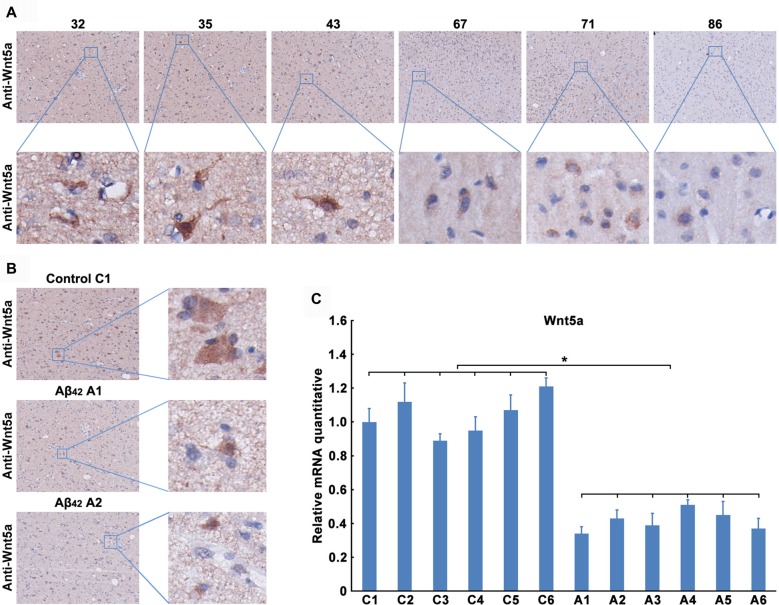
Aβ42 inhibited the expression of Wnt5a in vivo. (A) Wnt5a immunoreactivity was primarily detected in the adjacent normal brain tissues of malignant glioma from 32, 35, 43, 67, 71 and 86 years old patients (magnification of upper panel: ×40; magnification of lower panel: ×400). (B,C) A solution of Aβ42 (3 nmol/10 μl) or Aβ42 (3 nmol/10 μl) combined with recombinant Wnt5a protein (6 nmol/10 μl) was injected into the lateral ventricles of mice. Seven days after treatment, Wnt5a immunoreactivity was primarily detected in mouse brain tissues (B, control C1: control group mouse 1; Aβ42 A1: Aβ42 treated group mouse 1; Aβ42 A2: Aβ42 treated group mouse 2; magnification of left panel: ×40; magnification of right panel: ×400), total RNA was extracted and analyzed by Q-PCR (C, C1–C6: control group mouse 1–6; A1–A6: Aβ42 treated group mouse 1–6). All data in this figure represent the means ± SEM of three independent experiments. *P < 0.05.